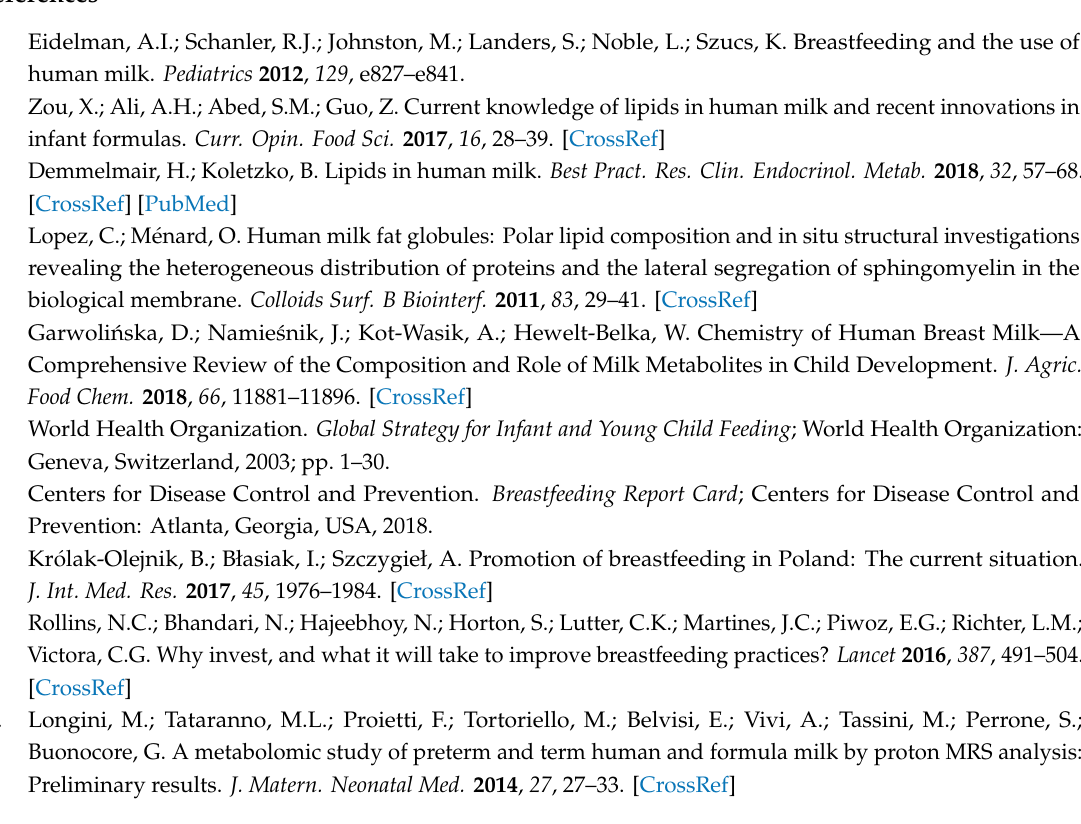
Inclusion criteria for HM sample donors. Table S1: Characteristics of the analysed milk samples. Figure S1: The fragmentation pattern for PIs, PSs and ether analogues of TGs and PEs. Table S2: List of the identified lipids included in the batch targeted extraction. Figure S2: The exemplary total ion chromatograms (TICs) of the lipid extracts of the FM and HM samples. Table S3: The percentage relative amount of lipid species within specific class of lipids in colostrum samples. Table S4: The percentage relative amount of lipid species within specific class of lipids in HM samples collected between 0 and 6 months. Table S5: The percentage relative amount of lipid species within specific class of lipids in HM samples collected between 7 and 12 months. Table S6: The percentage relative amount of lipid species within specific class of lipids in HM samples collected after 12 months. Table S7: The percentage relative amount of lipid species within specific class of lipids in FM samples. Table S8: The complete list of statistically significantly di ff erences between the colostrum and further lactation stage samples. Table S9: The complete list of lipids statistically significantly di ff erent between the colostrum and further lactation stage samples. Table S10: The complete list of statistically significantly ( p < 0.01) di ff erent lipids between the samples of caprine whole milk-based FM and FM supplemented with soy lecithin. Table S11: The complete list of lipids indicating a statistically significant ( p < 0.01) di ff erence between HM and FM samples in the di ff erent lactation stages and age range targets. Figure S3: Clustering shown as a heatmap for the top 80 TGs. Figure S4: Clustering shown as a heatmap for the PCs detected in HM and / or FM samples. Figure S5: Clustering shown as a heatmap for the SMs detected in HM and / or FM samples. Figure S6: Clustering shown as a heatmap for the PEs, PIs and PSs detected in HM and / or FM